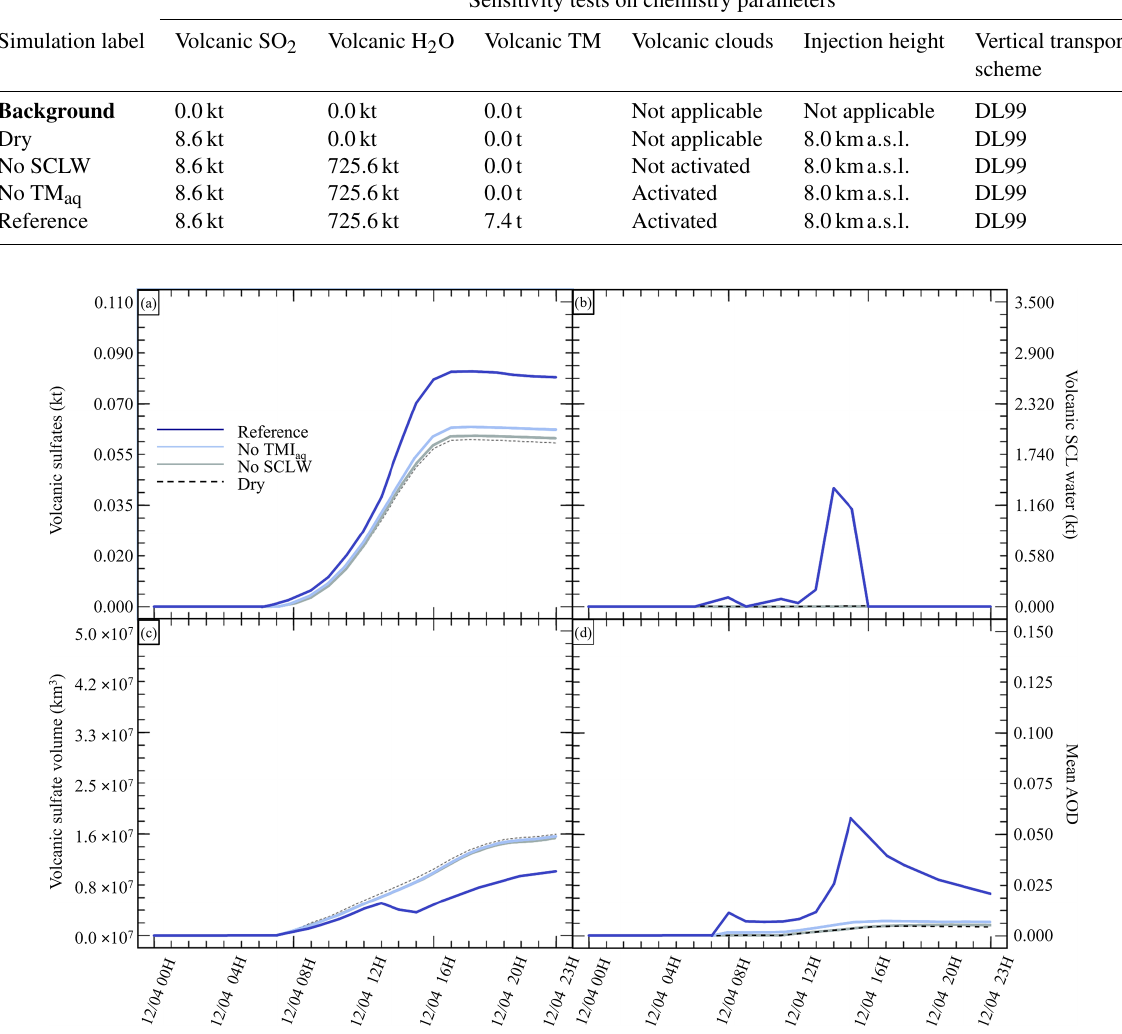
Figure 2. Sensitivity tests on chemistry parameters for (a) sulfate aerosols (SO 2 volume (km 3 ) ⊂ 25% of SO 2 − mass and (d) the AOD for plume ⊂ 25% of SO 2 − 4(p) realistic case. All time series represent differences relative to the Background simulation (the simulation without volcanic